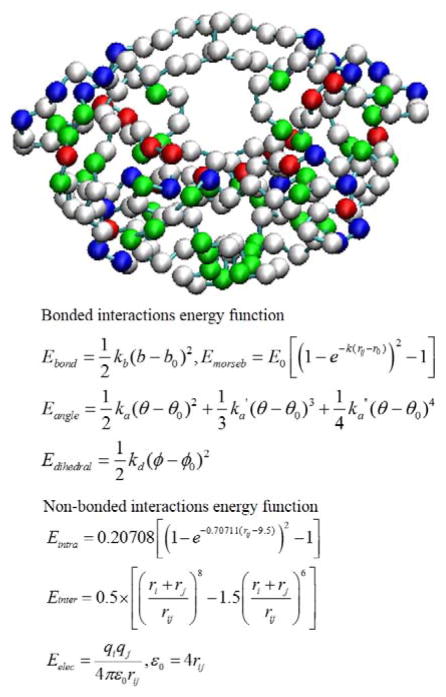
Representation of HIV-1 protease in the coarse-grained model and energy function of the force field. (Top) Each bead represents a residue, and positively charged, negatively charged and polar residues are in blue, red and green, respectively. (Bottom) The potential energy function of the force field for BD simulations, where r is the bond length; θ is the atomic angle; φ is the dihedral angle; rij is the distance in between atom i and j; kb, ka, kd, and E0 are force constants; and b0, θ0 and φ0 are equilibrium positions. ri and rj are the bead radius, and qi and qj are the charges on the respective bead. ε0 is the dielectric constant. Emorseb is the Morse potential, a term for computing the bond energy between two consecutive beads. Eintra and Einter are non-bonded interactions for rij < 8 Å and > 8 Å, respective. Detailed parameters are in ref [85,88].